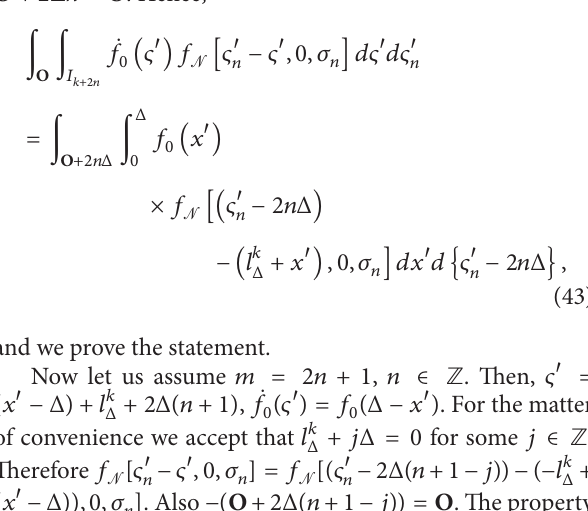
Figure 3: Analytic-based estimation of capacity under